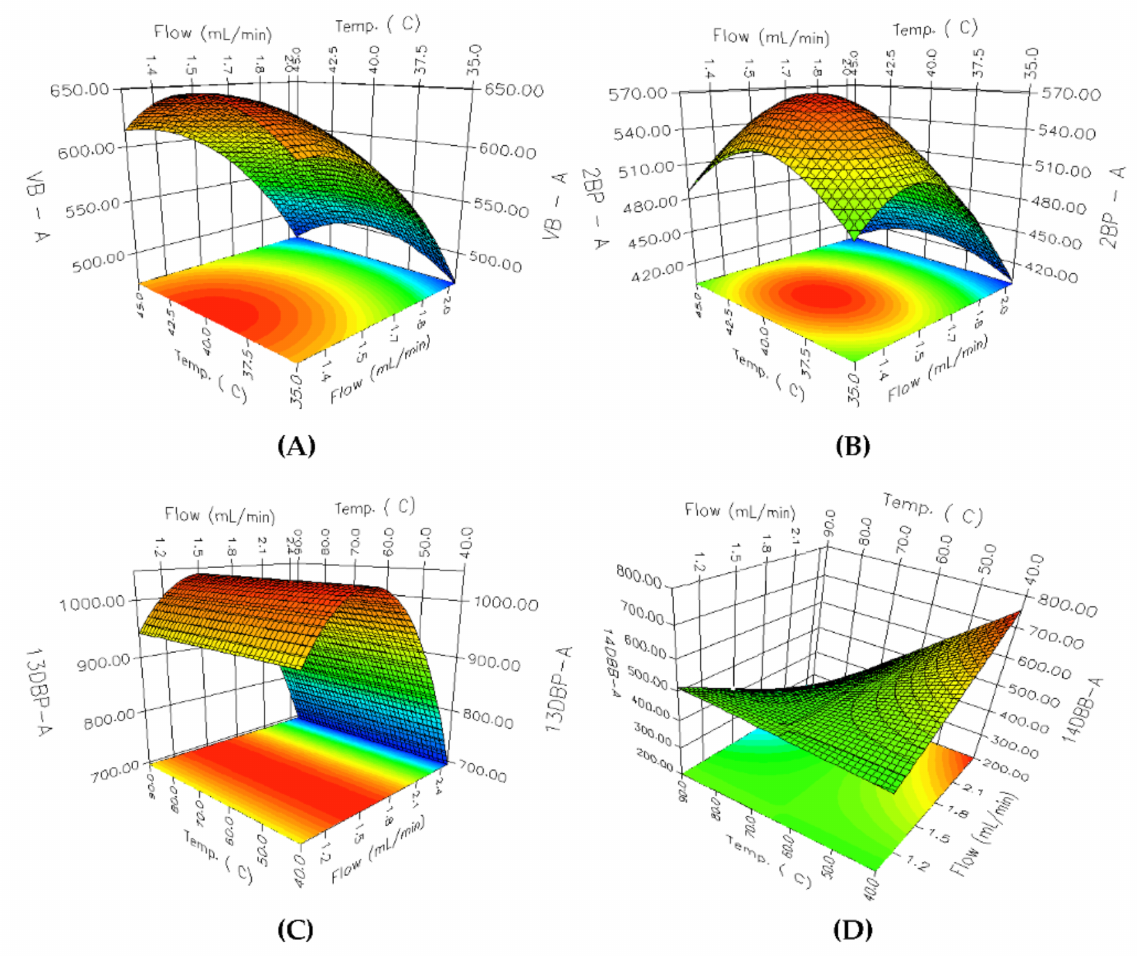
Figure 5. The 3D response surface plots for the peak area: ( A ) VB; ( B ) 2BP; ( C ) 13DBP; ( D ) 14DBB. According to the ICH Q14 guideline draft, the method operable design region